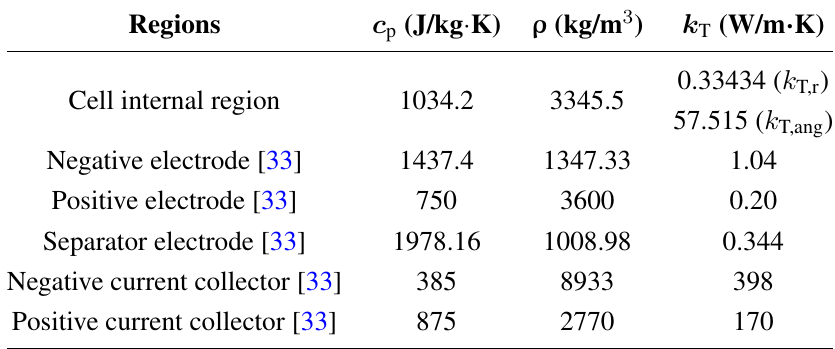
Table 3. Cell internal region, electrodes and separator thermo-physical